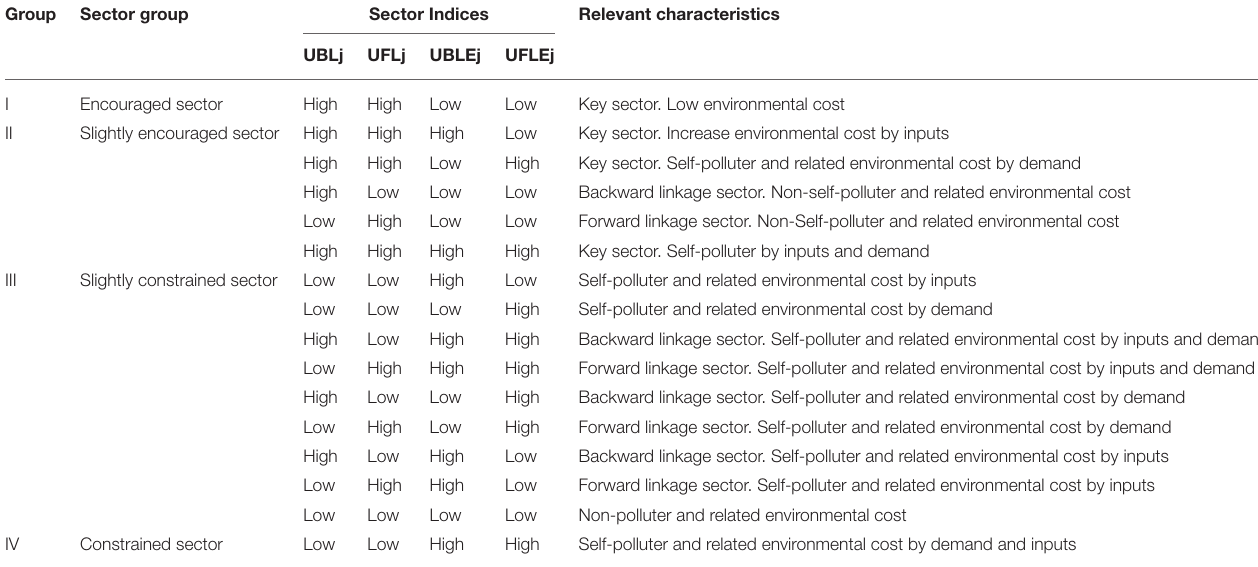
TABLE 1 | Classification of sectors in terms of the potential of environmental cost reduction. Group Sector